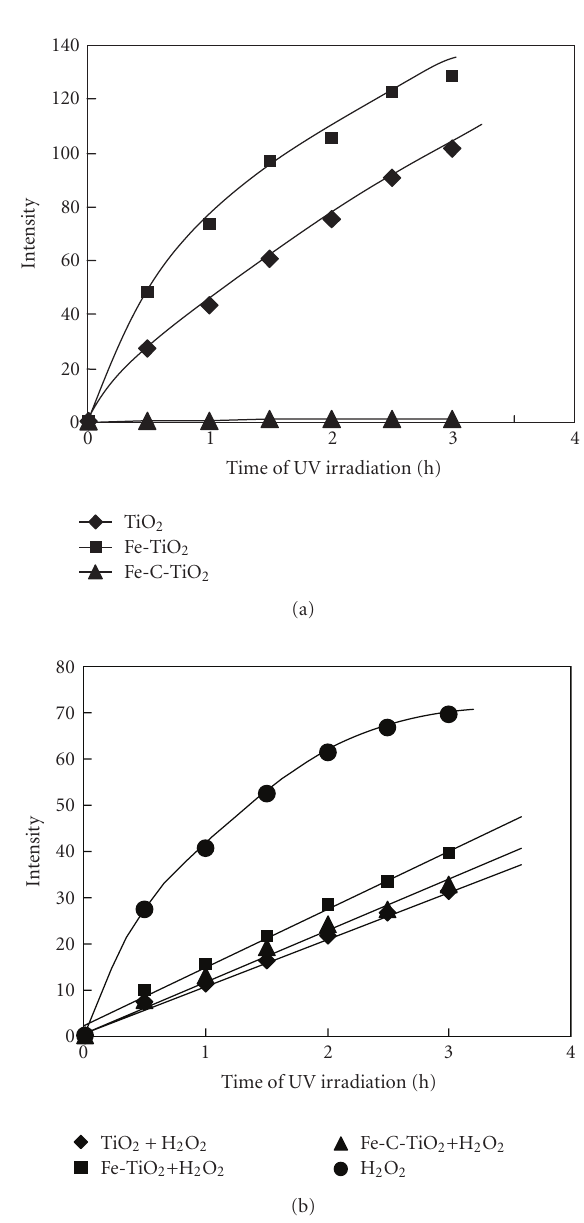
Figure 16: Formation of OH radicals on TiO 2 , Fe-TiO 2 , and Fe- C-TiO 2 prepared at 500 ◦ C, (a) under UV and (b) under UV with H 2 O 2